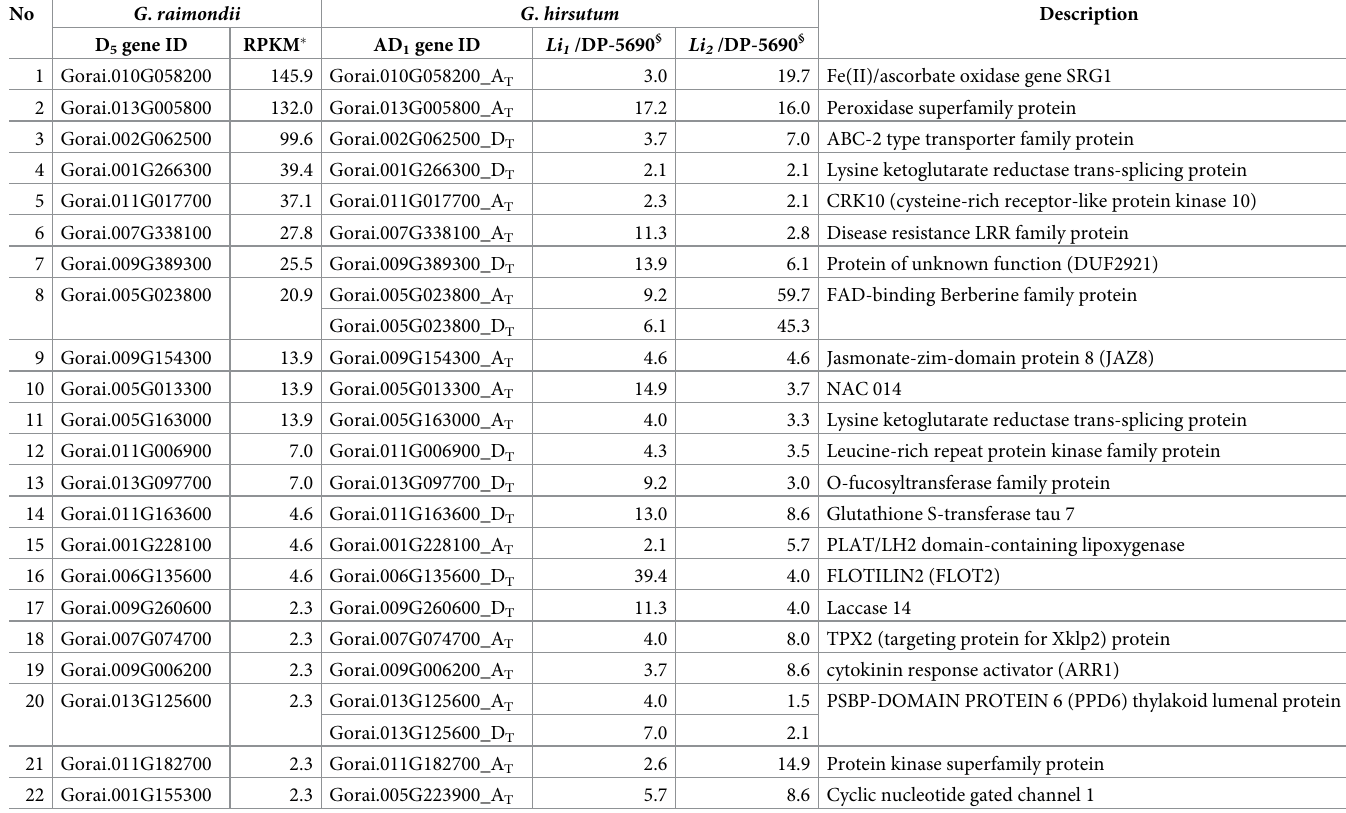
Table 5. Commonly up-regulated orthologous genes among developing G . raimondii D 5 , G . hirsutum Li 1 and Li 2 fibers at PCW stage. No G .